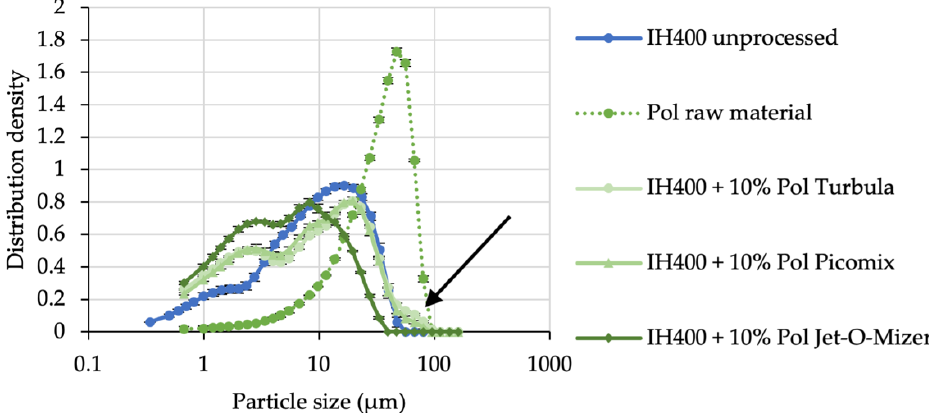
Figure 4. Resulting PSDs from the evaluation of particle engineering methods, which are unsuitable for extrinsic fines (exemplary shown for poloxamer processes). Turbula blender as low-shear blending is shown in light green circles, Picomix as exemplary for high-shear mixing is depicted in medium green triangles and the Jet-O-Mizer as co-milling approach is coloured in dark green squares. The black arrow points at the shoulder in PSD as a result of loose, residual additive. n = 3, error bars denote standard deviation.